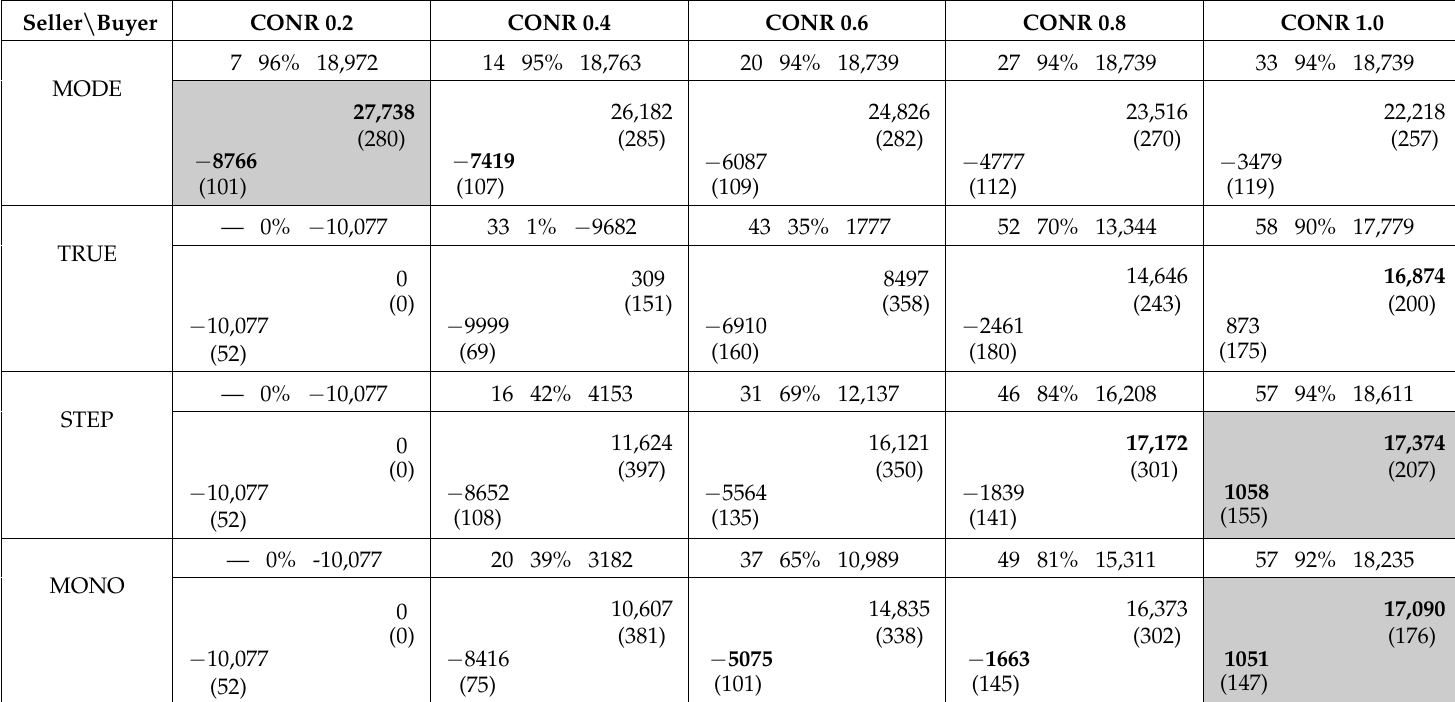
Table 2. Payoff matrix in the low-risk